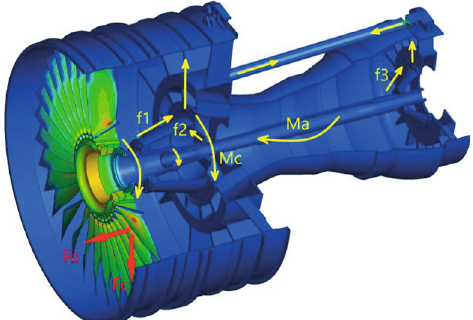
Figure 12: Dynamic load transfer mode and path due to bird